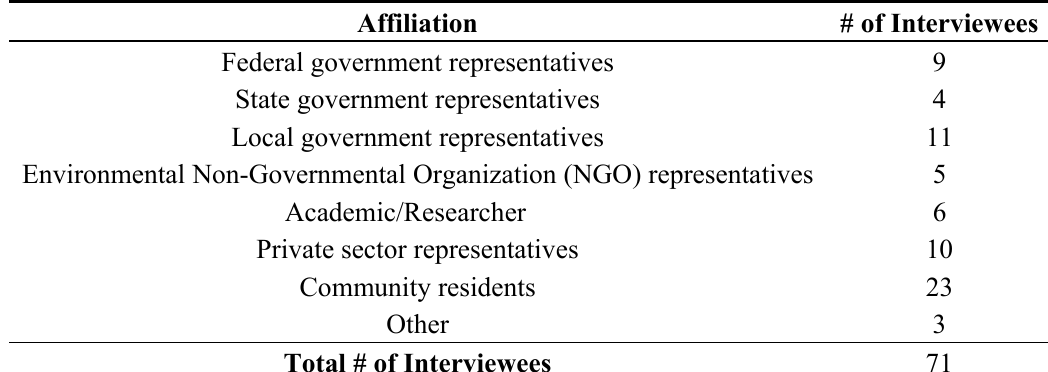
Table 1. List of interviewees by affiliation